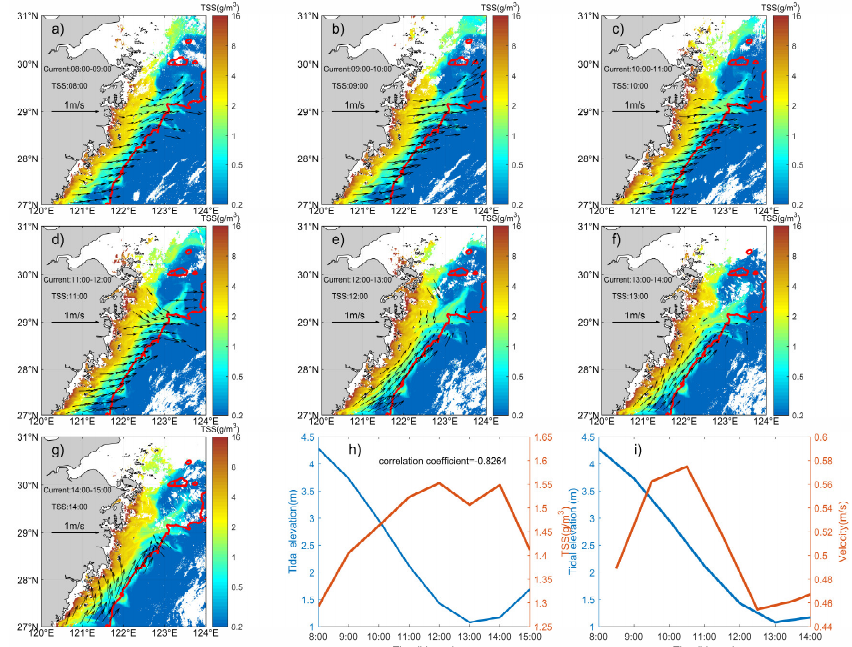
Figure 8. ( a – g ) Surface current field (red line represents the 70 m isobath); ( h ) tidal elevation observed from local tide gauge station (blue line) and spatially averaged TSS variation within 70 m isobath (red line); and ( i ) regional mean current velocity within 70 m isobath and tidal elevation from 8:00 to 14:00 on 3 August 2013. The variations in surface TSS are usually accompanied by both vertical and horizon- tal dynamical processes. To elucidate the main physical processes governing variations in surface TSS in the front zone along the Zhejiang coast, we conducted a diagnostic analysis based on the advection-diffusion equation for TSS [25], which is given below: